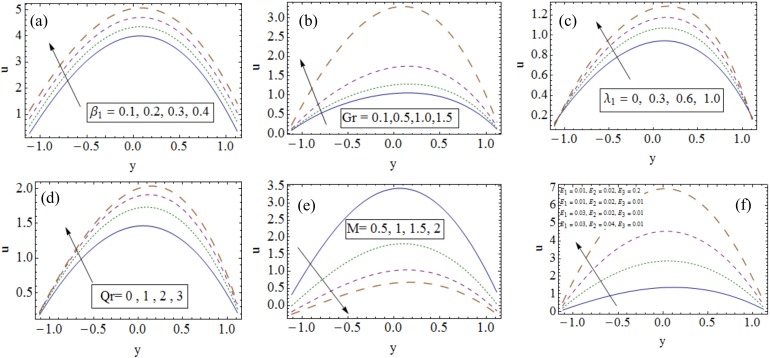
Influences of different parameters on velocity when (a). x = 0.2, t = 0.1, Pr = 1.5, Nt = 0.1, Nb = 0.1, Br = 1.7, Qr = 1, Gr = 1.5, ϵ = 0.2, M = 0.2, E1 = 0.01, E2 = 0.02, E3 = 0.01, β2 = 0.1, β3 = 0.1, λ1 = 1, Rn = 1. (b). x = 0.2, t = 0.1, Pr = 0.8, Nt = 0.3, Nb = 0.2, Br = 1.7, Qr = 1, ϵ = 0.2, M = 1, E1 = 0.01, E2 = 0.02, E3 = 0.01, β1 = 0.1, β2 = 0.1, β3 = 0.1, λ1 = 1, Rn = 1. (c). x = 0.2, t = 0.1, Pr = 0.8, Nt = 0.3, Nb = 0.2, Nt = 1.7, Qr = 1, Gr = 0.5, ϵ = 0.2, M = 1, E1 = 0.01, E2 = 0.02, E3 = 0.01, β1 = 0.1, β2 = 0.1, β3 = 0.1, Rn = 1. (d). x = 0.2, t = 0.1, Pr = 1, Nt = 0.1, Nb = 0.1, Br = 1.7, Gr = 1.5, ϵ = 0.2, M = 0.2, E1 = 0.01, E2 = 0.02, E3 = 0.01, β1 = 0.1, β2 = 0.1, β3 = 0.1, λ1 = 0.1, Rn = 1. (e). x = 0.2, t = 0.1, Pr = 1, Nt = 0.1, Nb = 0.1, Br = 0.5, Qr = 0.3, Gr = 1, ϵ = 0.2, M = 0.2, β1 = 0.1, β2 = 0.1, β3 = 0.1, λ1 = 1, Rn = 1. (f). x = 0.2, t = 0.1, Pr = 1.5, Nt = 0.1, Nb = 0.1, Br = 1.7, Qr = 1, Gr = 1.5, ϵ = 0.2, M = 0.2, β1 = 0.1, β2 = 0.1, β3 = 0.1, λ1 = 1, Rn = 1.